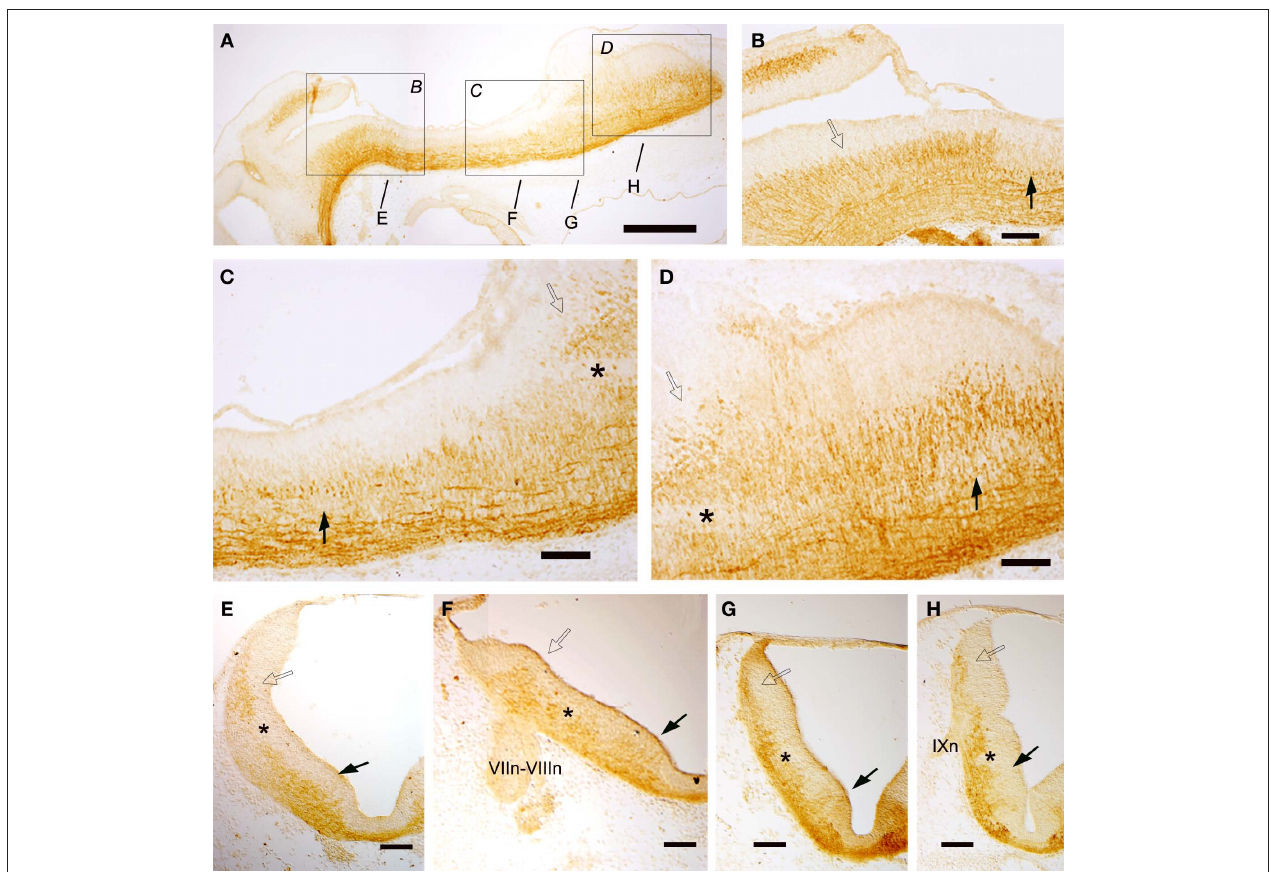
columns are continuous along the rhombencephalon from rostral to caudal levels (A–H) but from r4 these columns appeared subdivided into dorsal